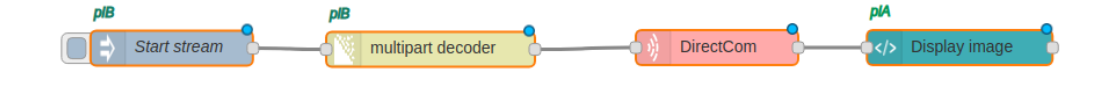
Figure 4. Live video transmission